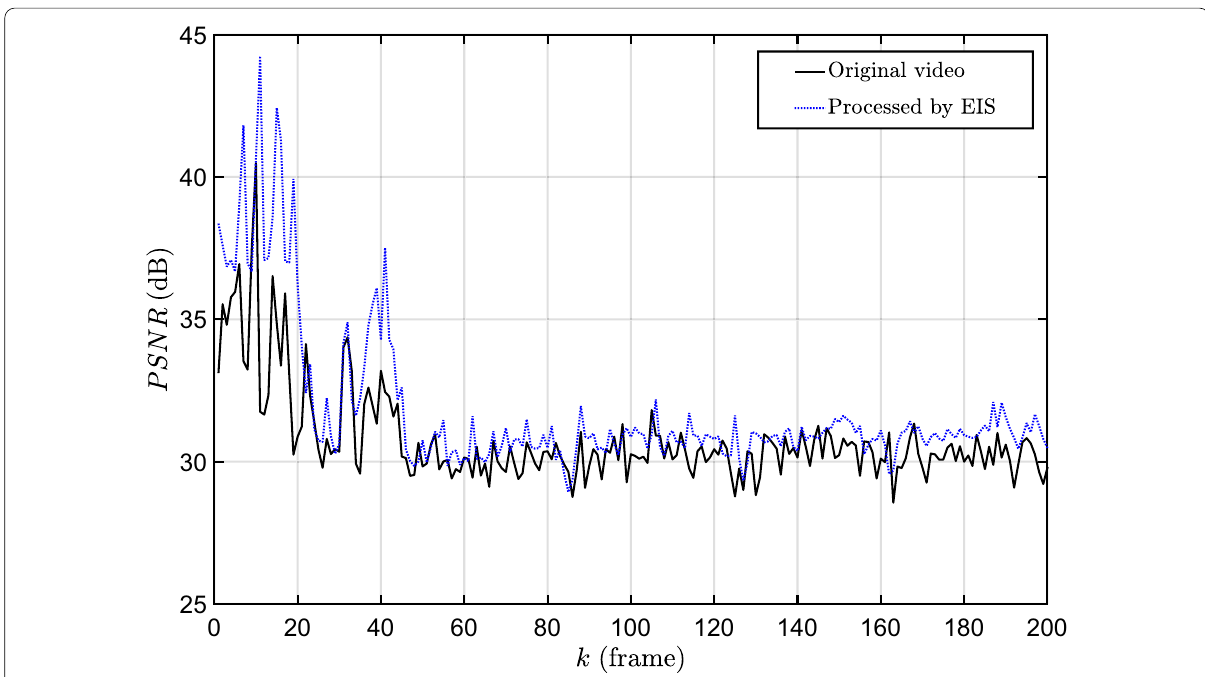
Figure 9 PSNR of the original video and the processed